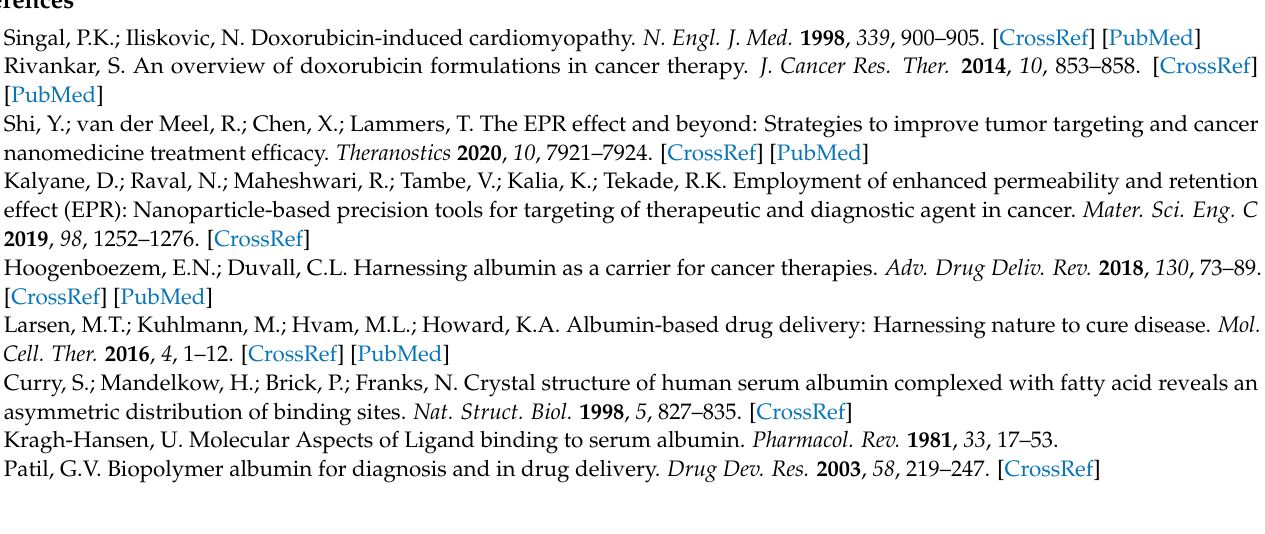
based polymer. Figure S3. 1 H (A) 13 C NMR (B) and MS (C) of NH 2 -PEG-NH 2 modified with SPDP. Figure S4. 1 H (A) and 13 C NMR (B) of PEI-PEG-PEI. In 1 H NMR, the PEG/PEI signal integrates in the ratio of 1:1.05, which corresponds approximately to the bi-functionalized PEG with PEI. In